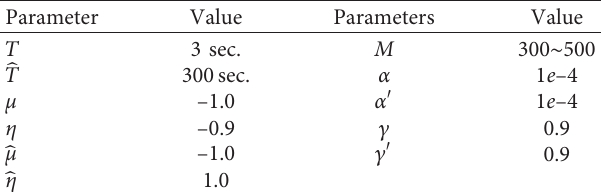
Table 2: System parameter setting of scheduling experiment.